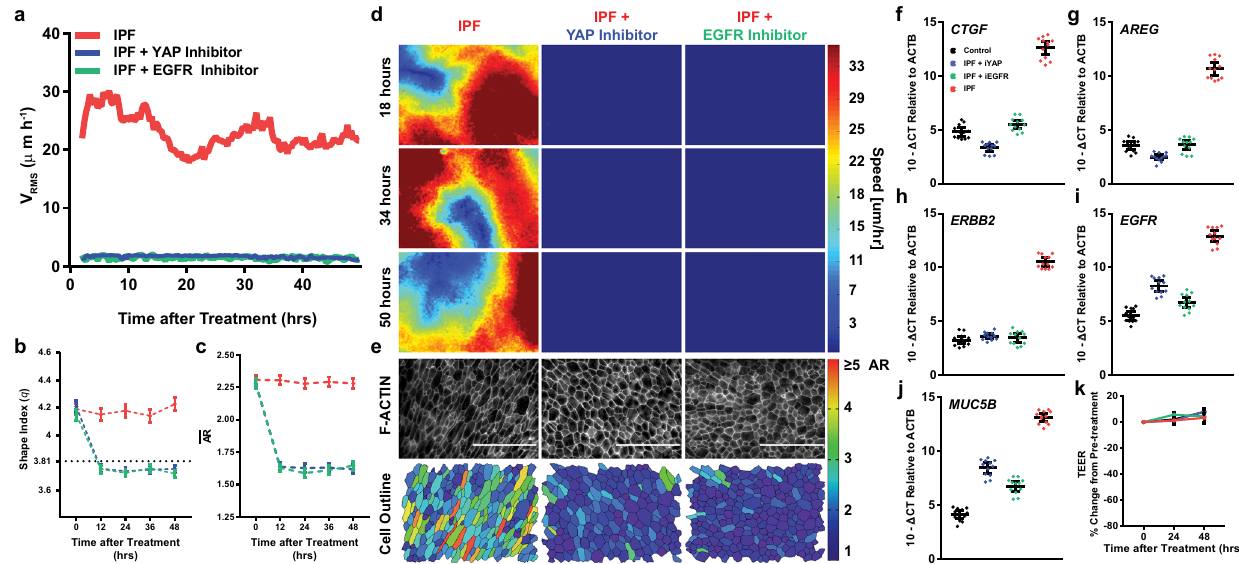
Fig. 3 Inhibition of EGFR and YAP induce jamming in IPF distal epithelia. Distal airway IPF cells were treated at day 14 for ALI with Vertepor fi n (YAP inhibitor) or AG1478 (EGFR inhibitor) ( a ) and fi lmed continuously for 48 h demonstrating a cessation of collective migration as assessed by V RMS . Cell shape ratio measurements, perimeter-to-area ( b ) and aspect ( c ) were taken every 12 h after treatment initiation and illustrated the acquisition of a cobblestone-like phenotype which persisted for the entire duration of the measurement (up to 48 h). Representative speed maps taken every 16 h after treatment ( d ) and cell boundary segmentation at 48 h after treatment ( e ) demonstrate a concordant cessation in migration and acquisition of a cobblestone-like apical surface, color coded by aspect ratio (AR) of the epithelium consistent with a jammed state. IPF epithelia treated with Vertepor fi n or AG1478 had reduced YAP target gene expression AREG ( f ) and CTGF ( g ) as well as ERBB family receptor ERBB2 ( h ) and EGFR ( i ) 48 h after treatment, nearly back to control epithelial levels. In addition, gene expression of MUC5B ( j ) was also decreased after treatment. Inhibition of YAP or EGFR did not signi fi cantly impact barrier function as assessed via TEER ( k ) with marginal increased barrier function occurring after treatment. Shown: mean ± 95% con fi dence interval for n = 3 donors (control epithelia) and n = 4 donors (IPF epithelia) with (cid:2) 2 replicates and scale bars representing 100 μ